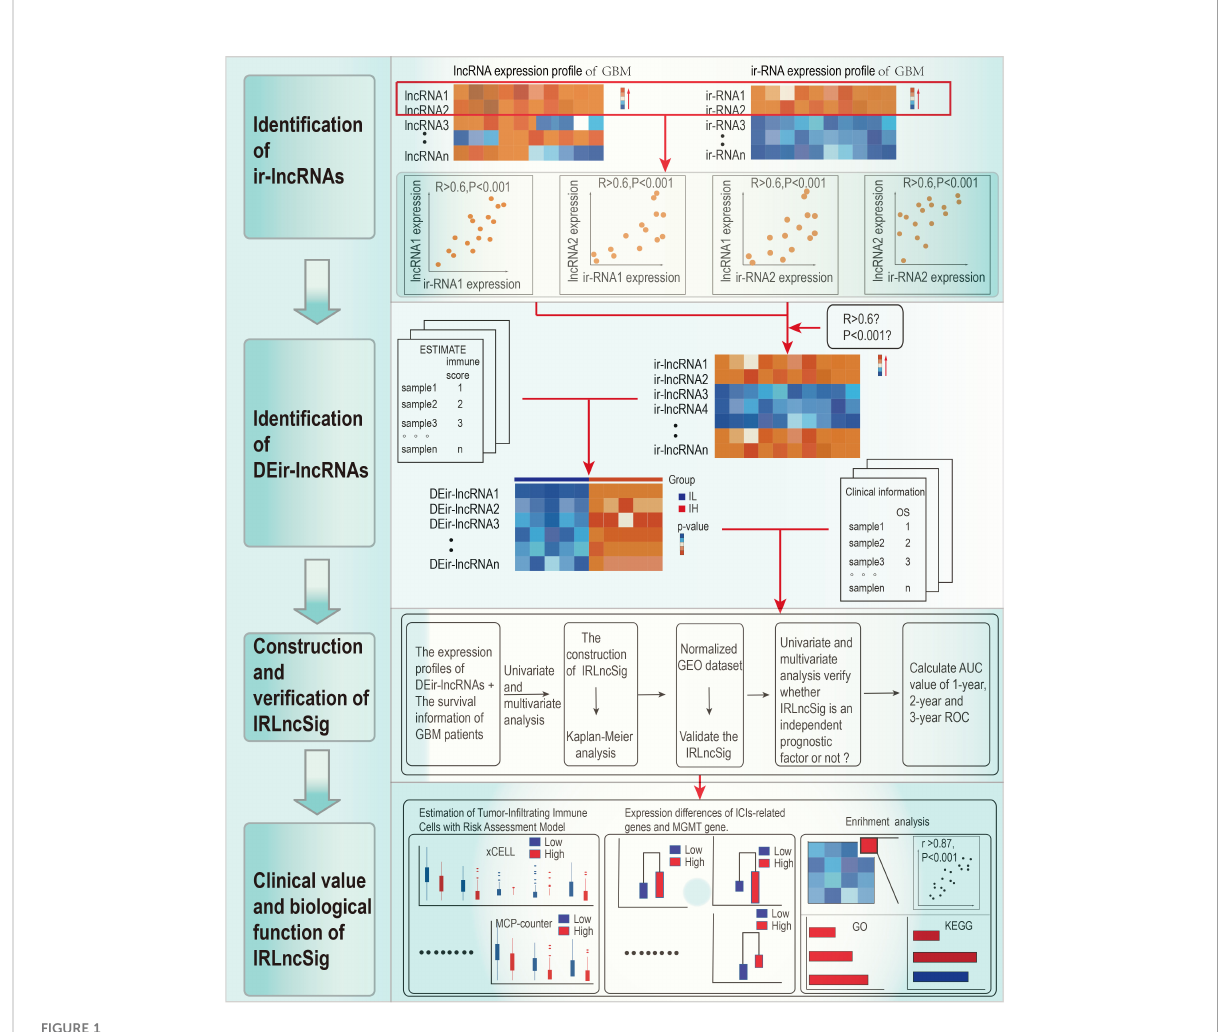
FIGURE 1 Study fl ow